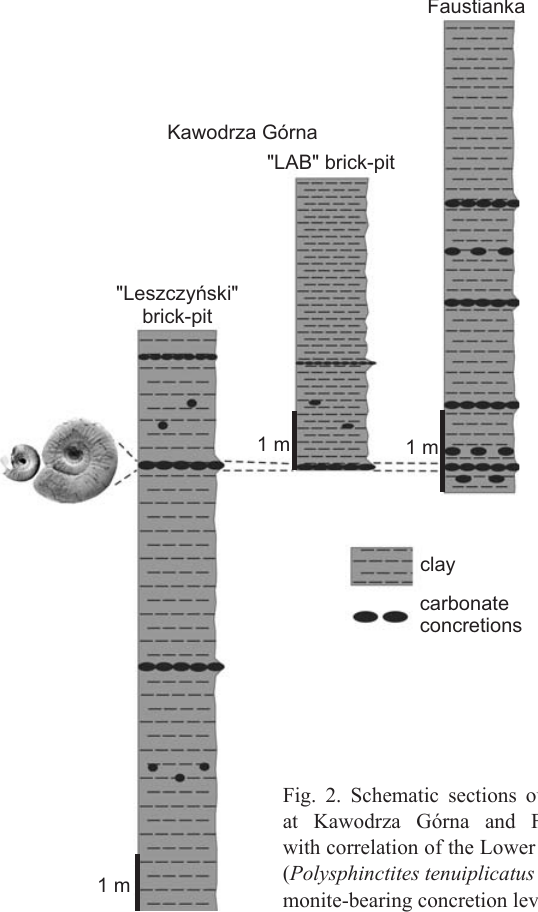
Fig. 2. Schematic sections outcropping at Kawodrza Górna and Faustianka, with correlation of the Lower Bathonian ( Polysphinctites tenuiplicatus Zone) am- monite-bearing concretion